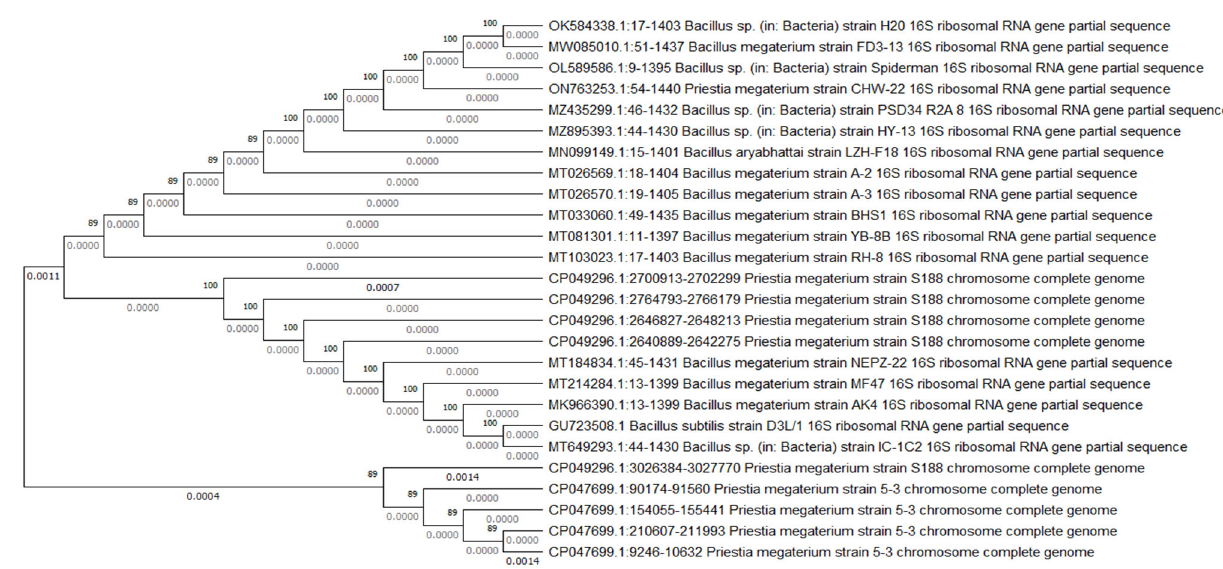
Figure 2. A neighbor joining phylogenetic tree of representative B. subtilis and B. megaterium. The optimal tree is shown (next to the branches). The percentage of replicate trees in which the associated taxa clustered together in the bootstrap test (500 replicates) are shown next to the branches. The evolutionary distances were computed using the p ‐ distance method and are in the units of the number of base differences per site. This analysis involved 26 nucleotide sequences. All ambiguous positions were removed for each sequence pair (pairwise deletion option). There were a total of 1387 positions in the final dataset. Evolutionary analyses were conducted in MEGA11.